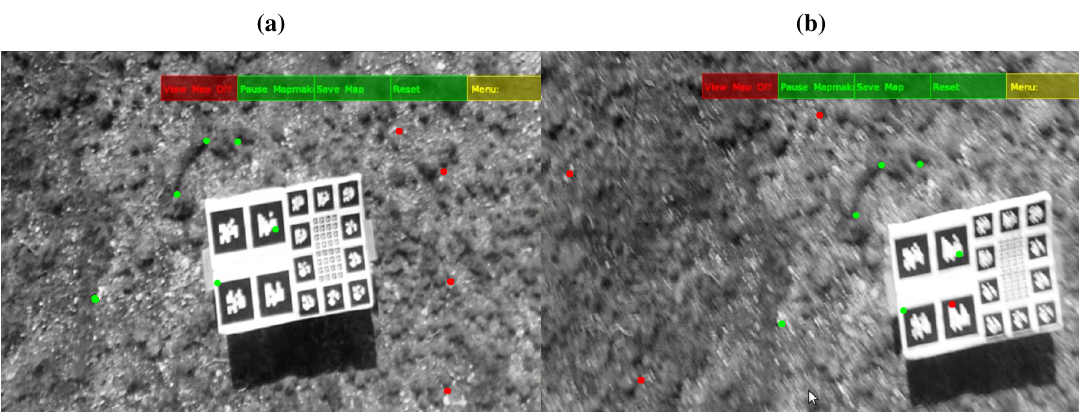
Screen captures of the system output in two different frames highlighting a selection of ten significant static points in each frame. The frames (a) and (b) are not consecutive. In this example we have selected two frames separated by one second to better appreciate the differences between the frames. Green points mark features that are appear in the two frames. Red points mark the rest of the